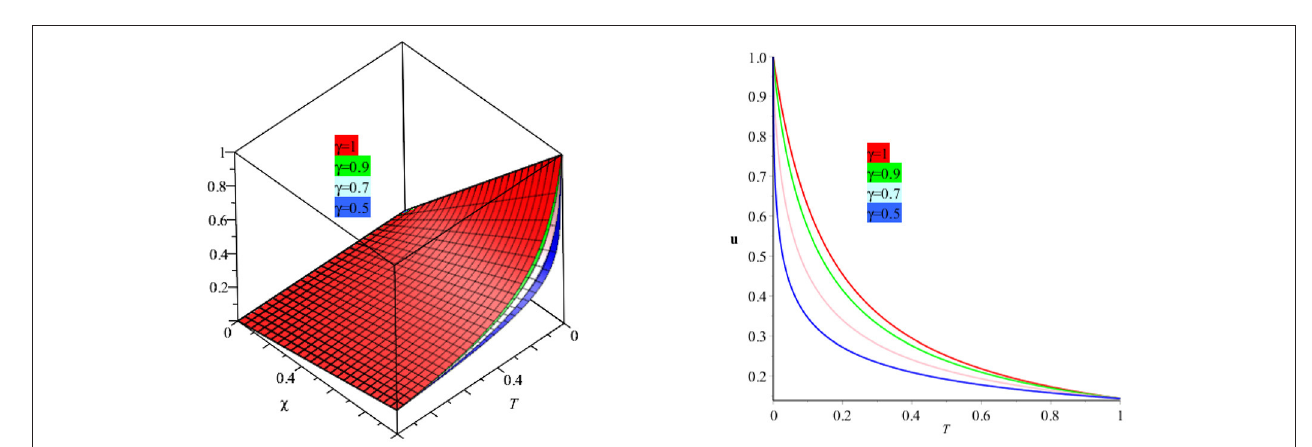
FIGURE 2 | Represents the solution at different fractional